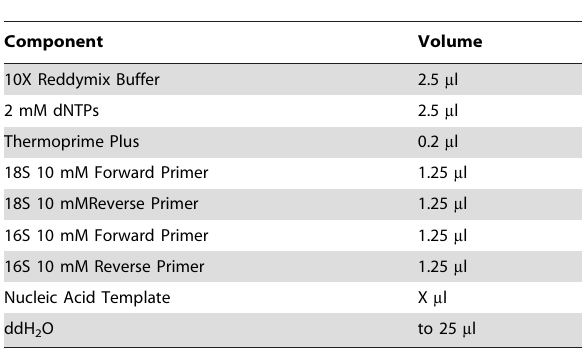
Table 2. Recipe for the assay PCR mixture.